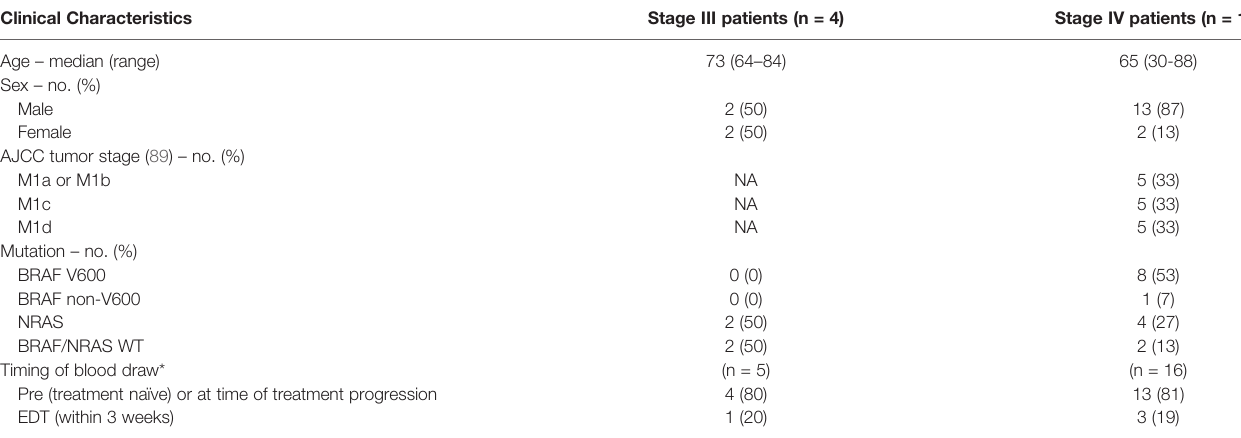
TABLE 1 | Patient characteristics.